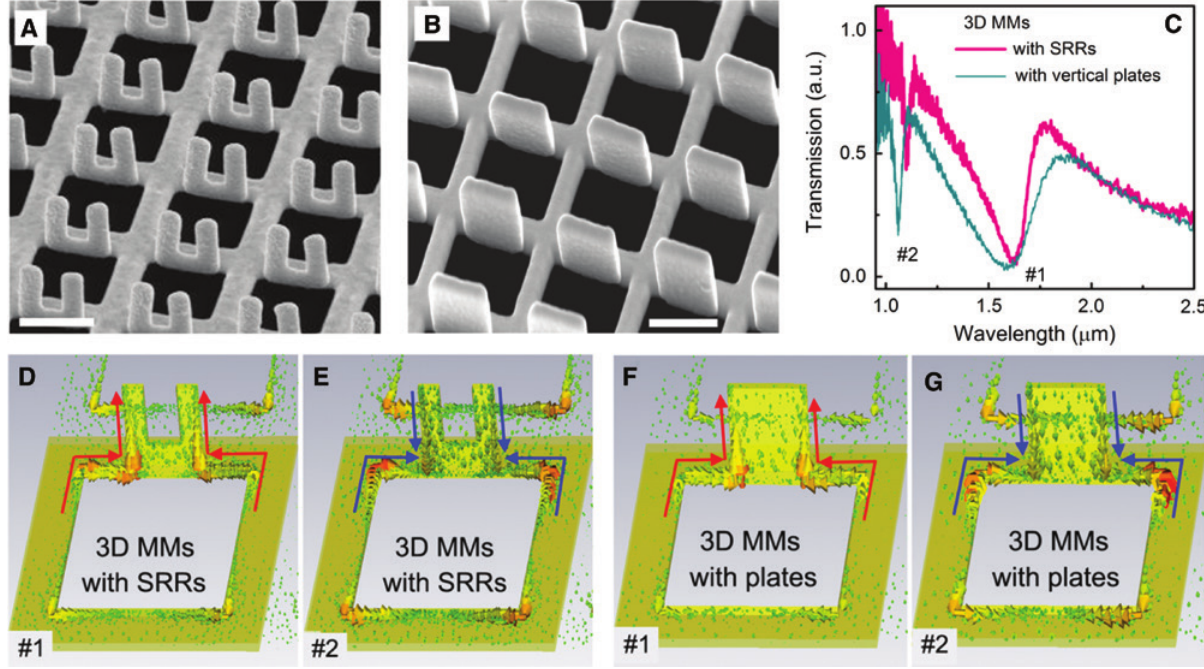
Figure 7: 3D conductive-coupling-induced significant Fano resonances [31]. (A, B) SEM images of 3D metamaterials (MMs) with (A) vertical SRRs and (B) vertical plates standing along metallic hole arrays, which were folded upward by local FIB irradiation. Scale bars: 500 nm. (C) Measured transmission spectra of the structures in (A, B) under y -polarized light excitation, which have similar profiles with two resonance modes #1 and #2, respectively. (D–G) Simulated current distributions of the two structures with vertical (D, E) SRRs and (F, G) plates, respectively, at the wavelength of modes #1 and